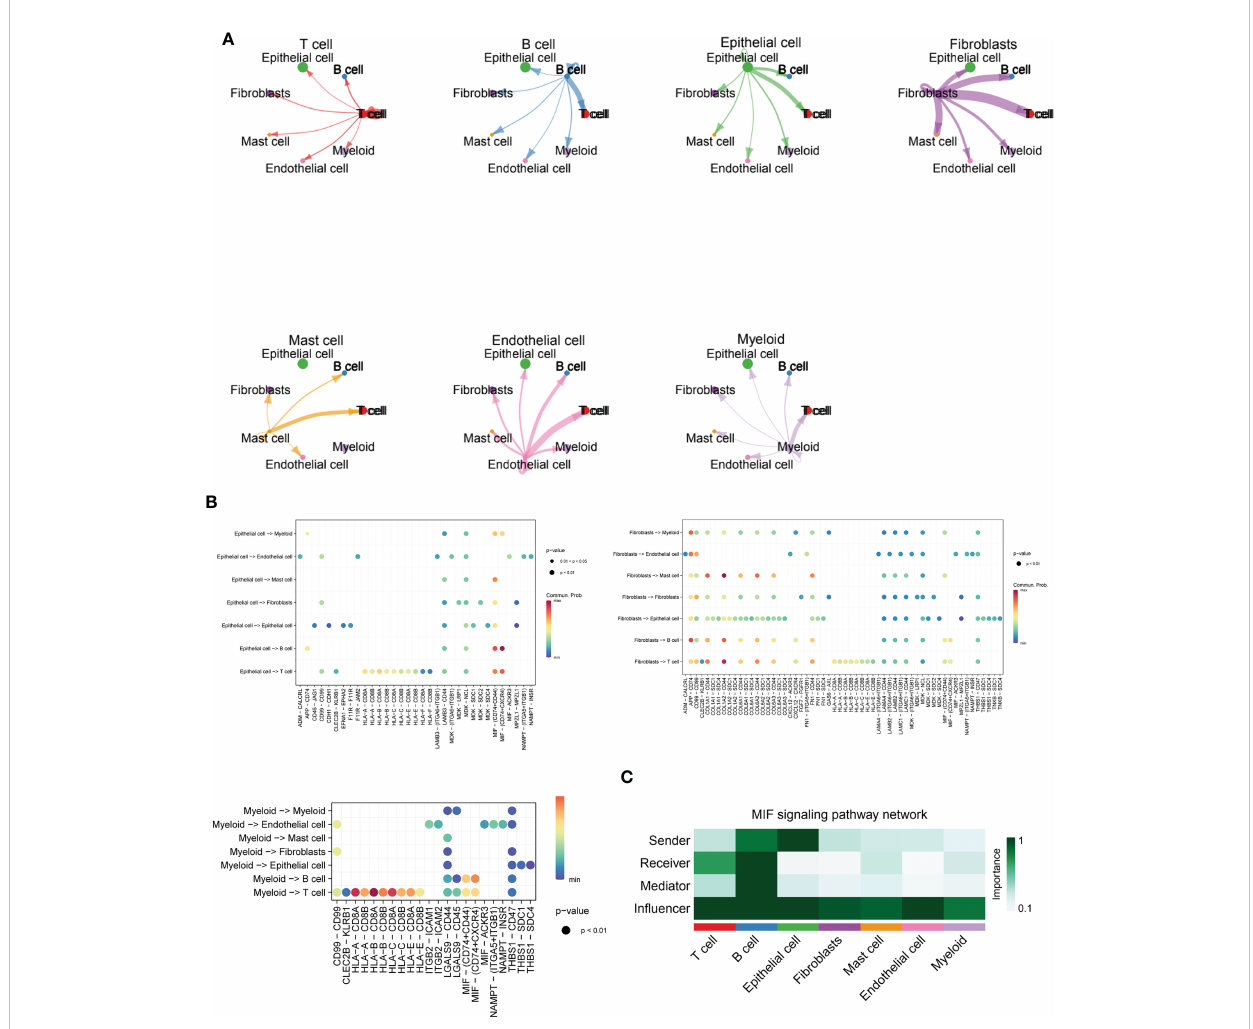
FIGURE 3 Cellchat and MIF signalling communication between immune cell types in ESCC. (A) Cross-correlation map of immune cell types obtained from single-cell sequencing data of ESCC patients, including T cells, B cells, Fibroblasts, Mast cells, Endothelial cells, and Myeloid cells; (B) Bubble plots further quantitatively visualize the major intercellular links of several lysosomal-high cells as well as mediating cytokines, including Fibroblasts, Myeloid, and Epithelial cells. (C) . Heat map demonstrating the prominence of each cell subpopulation as a major sender, receiver, mediator and in fl uencer at the centre of the MIF secretory signalling communication network. B cells and EPITHELIAL cells play the role of major MIF signal senders. B cells are also important Receivers and Mediators, while throughout the MIF signalling pathway, T cells, B cells as well as Epithelial cells played a major In fl uencer role in the overall MIF signalling